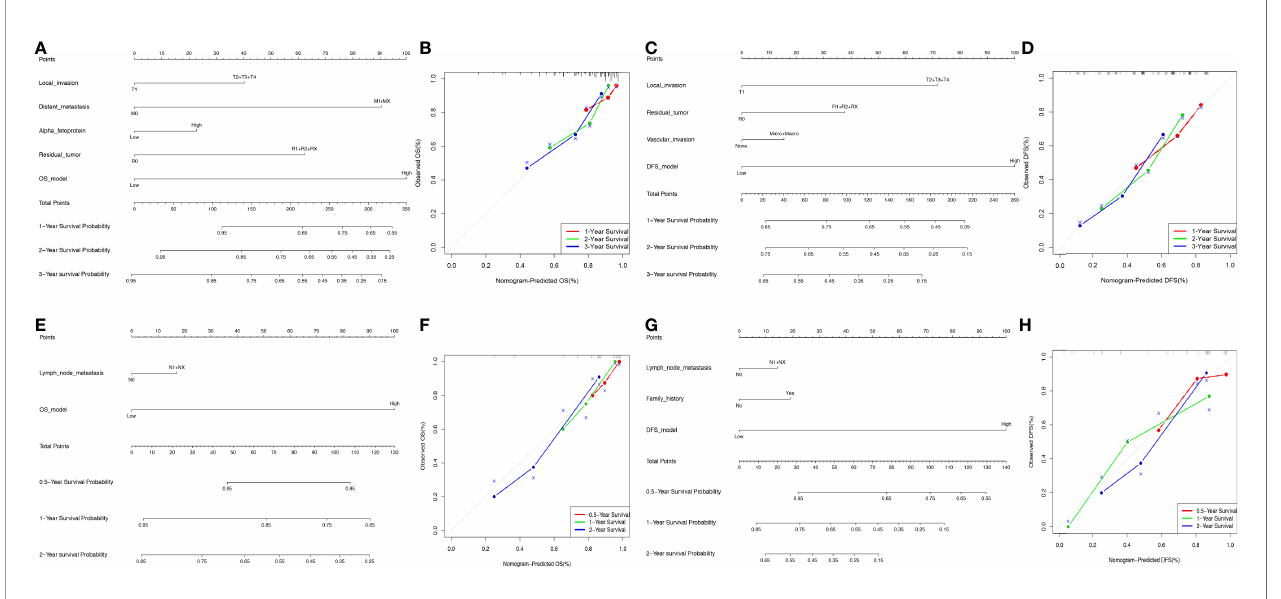
FIGURE 6 | Nomogram model construction in HCC and ICC. (A, B) The development of nomogram to predict the 1-, 2-, and 3-year OS in HCC (A) , and the corresponding calibration (B) . (C – D) The development of nomogram to predict the 1-, 2-, and 3-year DFS in HCC (C) , and the corresponding calibration (D) . (E, F) The development of nomogram to predict the 0.5-, 1-, and 2-year OS in ICC (E) , and the corresponding calibration (F) . (G, H) The development of nomogram to predict the 0.5-, 1-, and 2-year OS in ICC (G) , and the corresponding calibration (H)